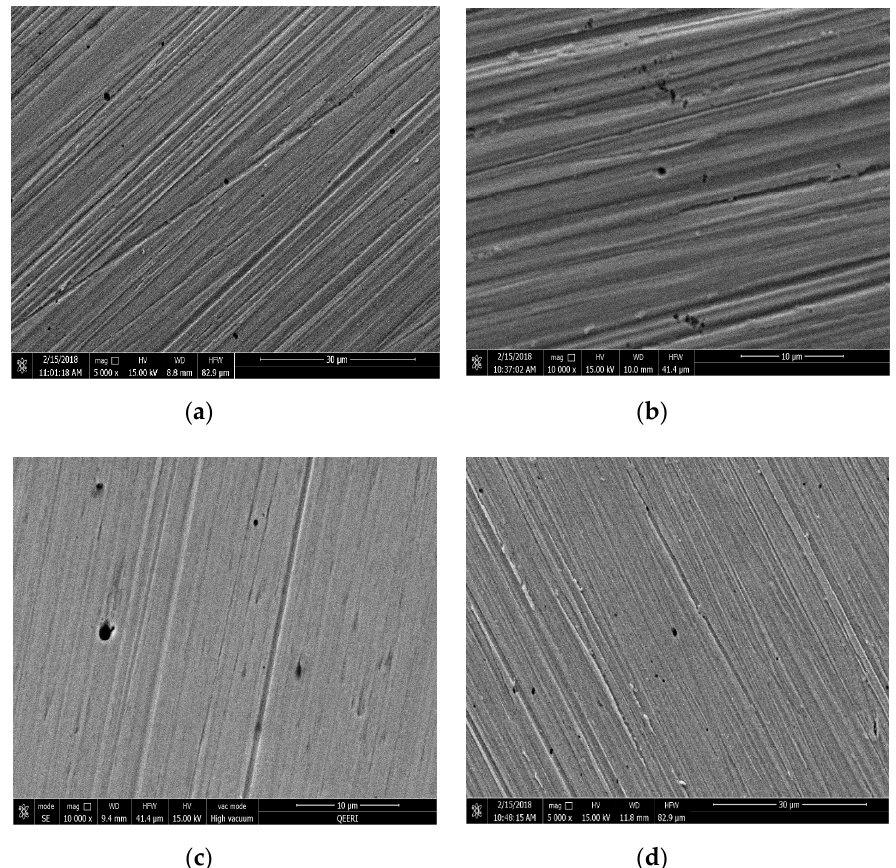
Figure 9. SEM images for 316L stainless steel samples after the potentiodynamic testing in different CNT loading of CNT-water nanofluid, after washing ( a ) 0.05, ( b ) 0.1, ( c ) 0.3 and ( d ) 0.5